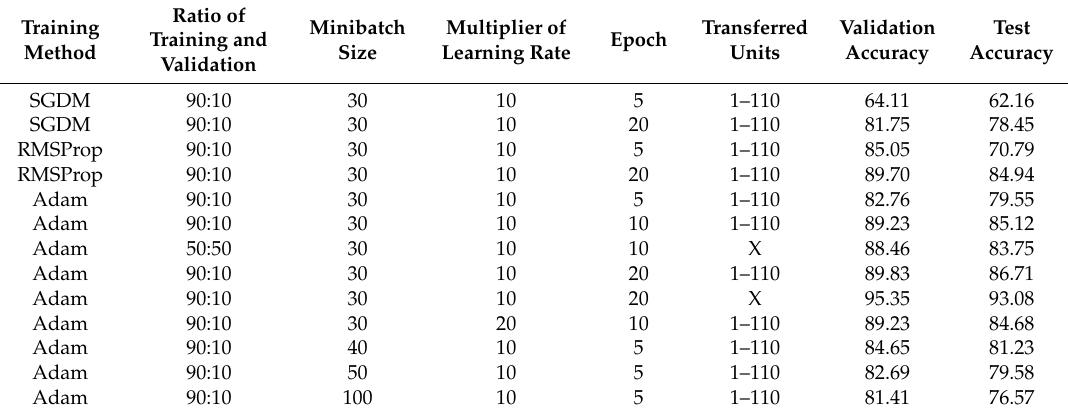
Table 8. Performance of googleNet on CU-ECG.